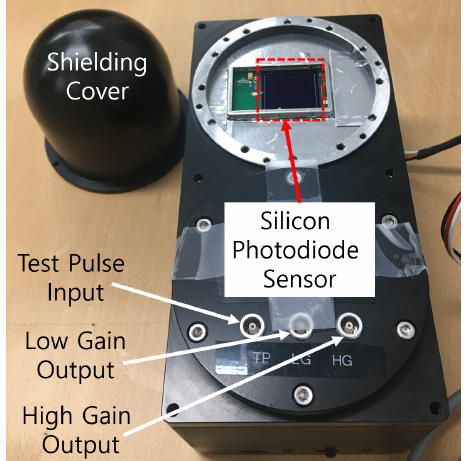
Figure 2. Photograph of a Silicon Particle Dosimeter and Spectrometer